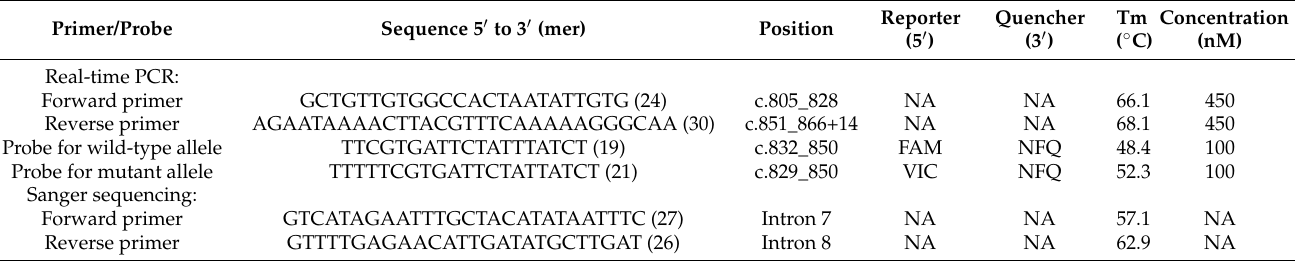
Table 1. Sequences of the primers and probes used in the real-time PCR assay and Sanger sequencing for the c.846delT mutation in the canine CLN7 / MFSD8 gene.